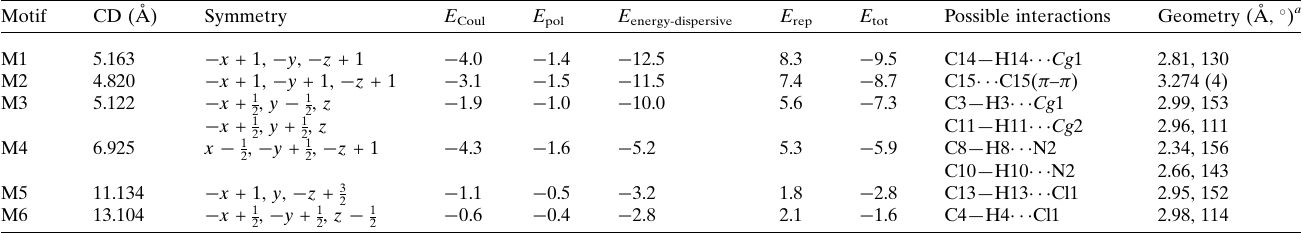
Table 2 Intermolecular interaction energies (in kcal mol (cid:3) 1 ) for different molecular pairs observed in the major component of the title compound; CD is the centroid-to-centroid